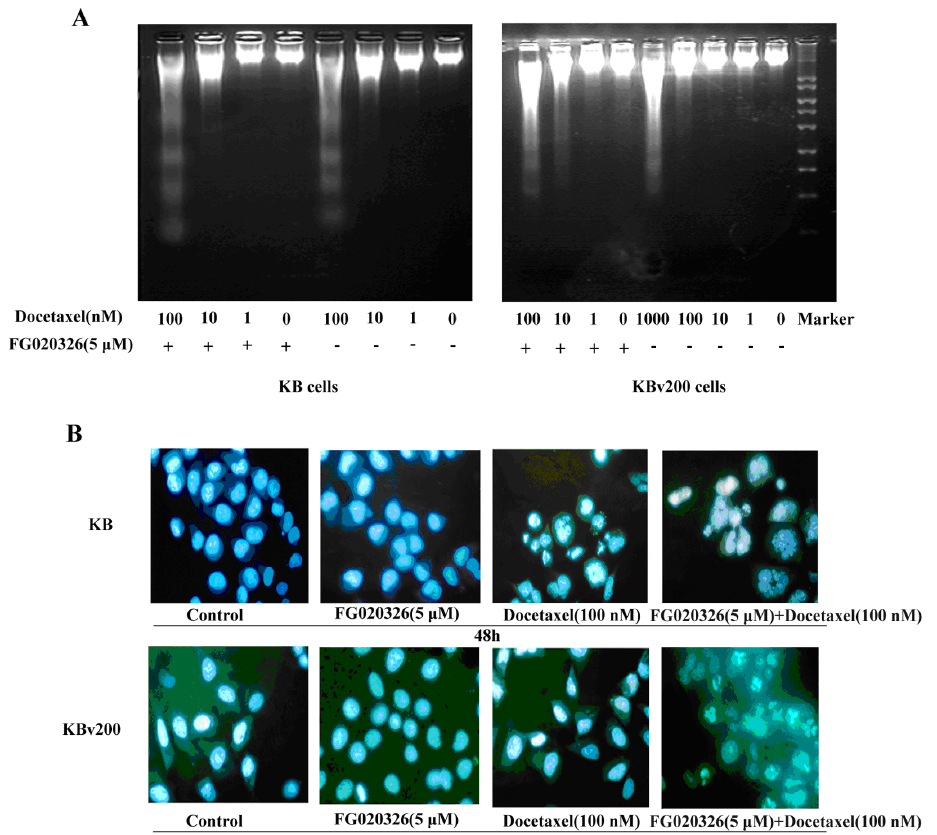
Figure 2. ( A ) DNA fragmentation in KB and KBv200 cells exposed to docetaxel in the presence or absence of FG020326. DNA obtained from KB and KBv200 cells exposed to various concentration docetaxel for 48 h in the presence or absence of 5 μ M docetaxel, respectively; ( B ) Apoptotic morphology of KB and KBv200 cells (×400) by Hoechst 33258. Cells were treated with docetaxel in the presence or absence of FG020326. The cells were stained by Hoechst 33258, apoptotic cells were identified by their typical appearance of condensed and fragmented